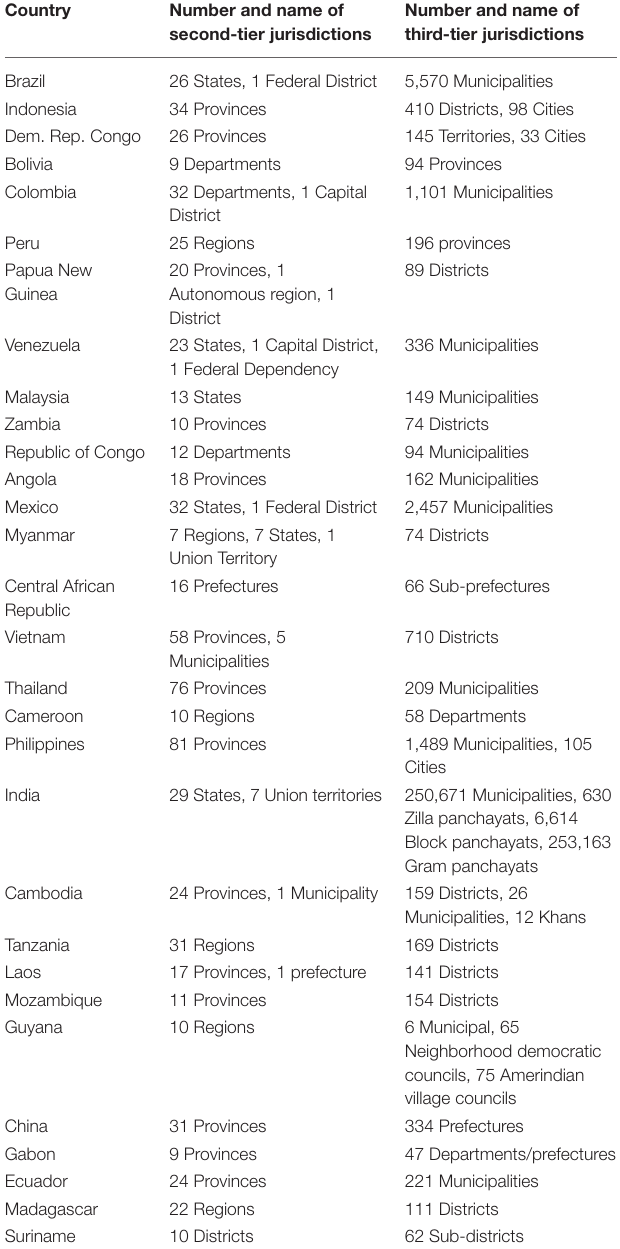
TABLE 1 | Numbers and names of sub-national jurisdictions in 30 tropical countries with greatest projected emissions from deforestation.